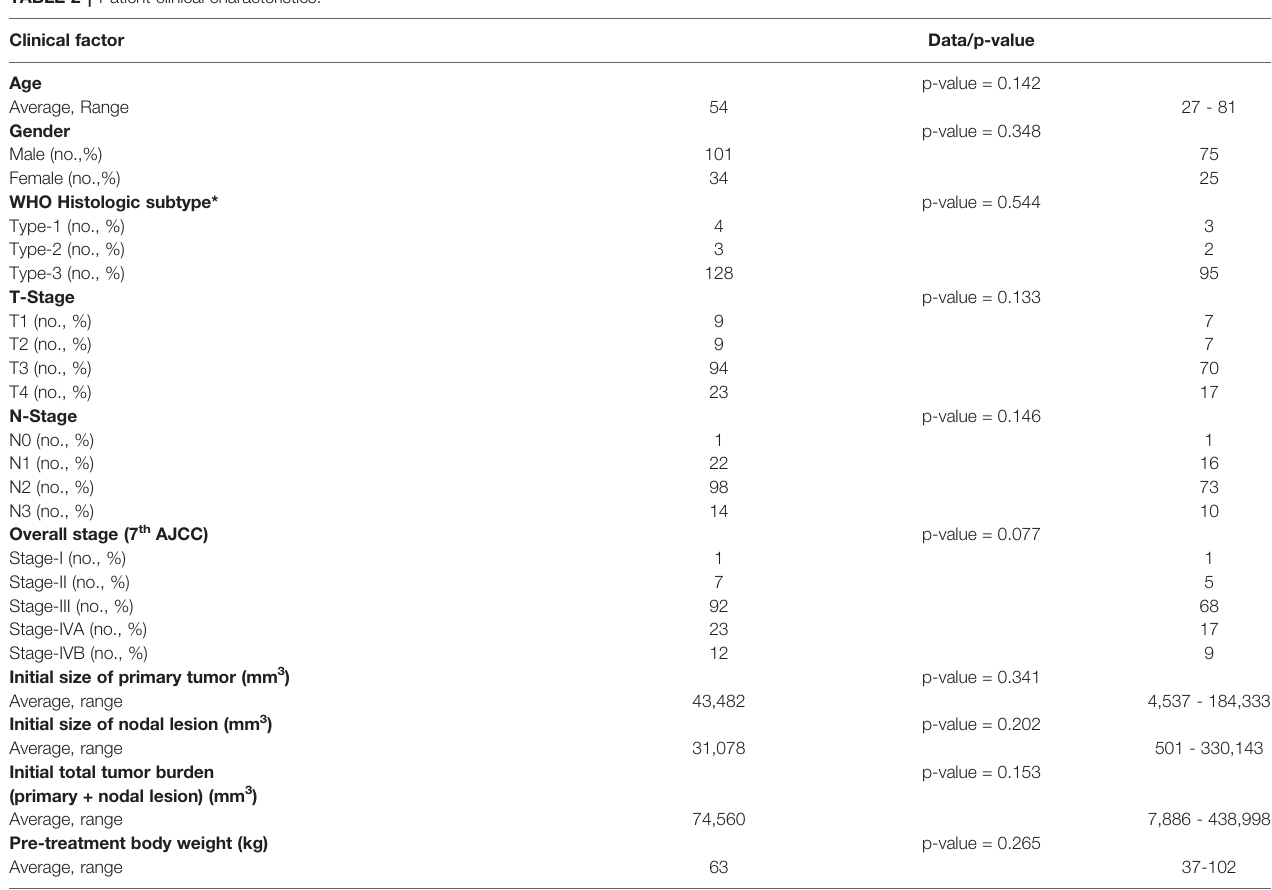
TABLE 2 | Patient clinical